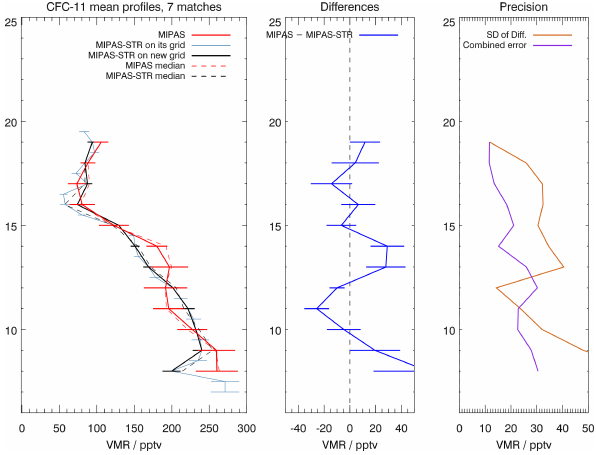
Figure 5. Comparison of mean profiles of MIPAS CFC-11 (left panel, continuous red line) and MIPAS-STR (left panel, continuous black line) for seven collocated measurements taken during a flight on 2 March 2010. The error bars consist of the total error with- out the spectroscopy error for both MIPAS and MIPAS-STR. The dashed lines show the median of each data set. The middle panel shows the mean difference (blue) of these profiles and the standard error of the mean. The right panel shows the combined error (pur- ple) of the instruments and the standard deviation of the differences